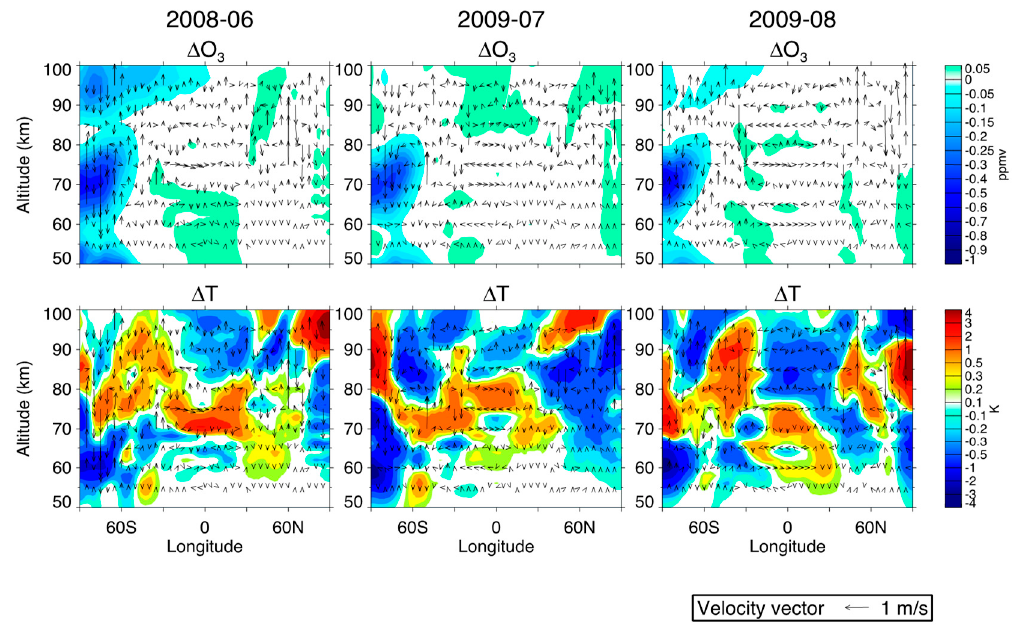
Figure 11. Latitudinal variations of the differences (MEE-Control) of the monthly zonal mean ozone (top panels) and temperature (bottom panels) in the altitude range of 50–100 km in June 2008, July 2009, and August 2009 (around low geomagnetic activity/solar minimum period). The differences of residual mean velocity vector ( v *, w *) are also displayed by arrows in the figure. For a better visualization, w * was multiplied by 333 in the residual mean velocity vector.